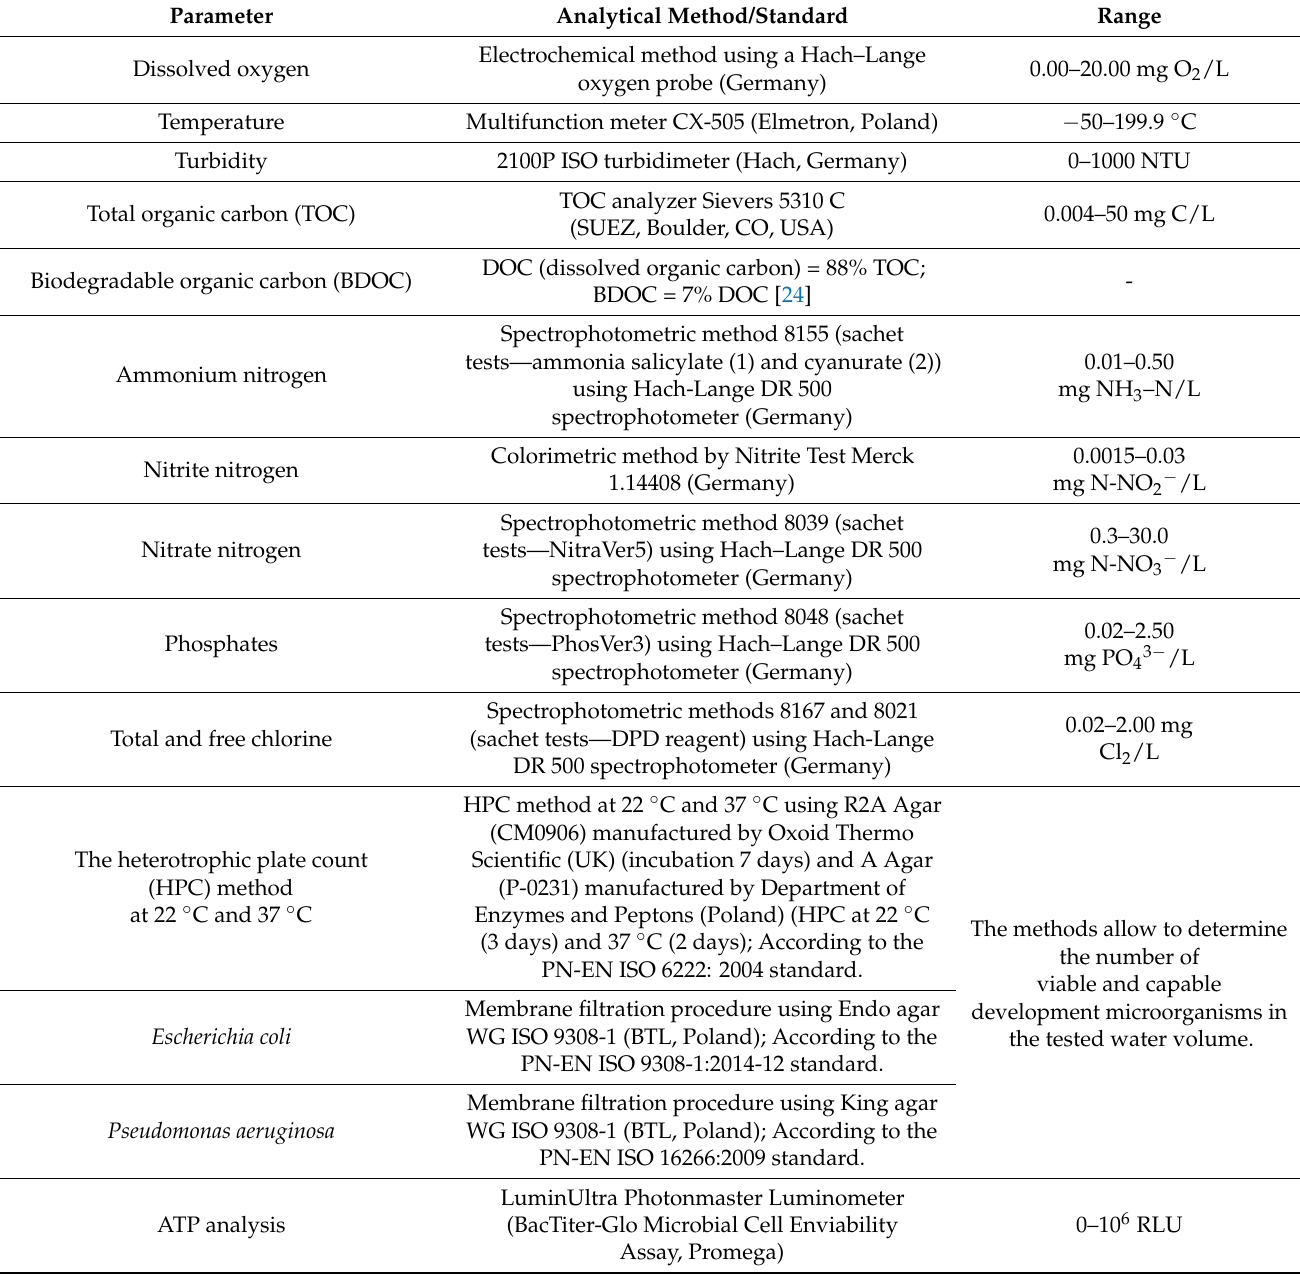
Table 1. Summary of analytical methods for laboratory